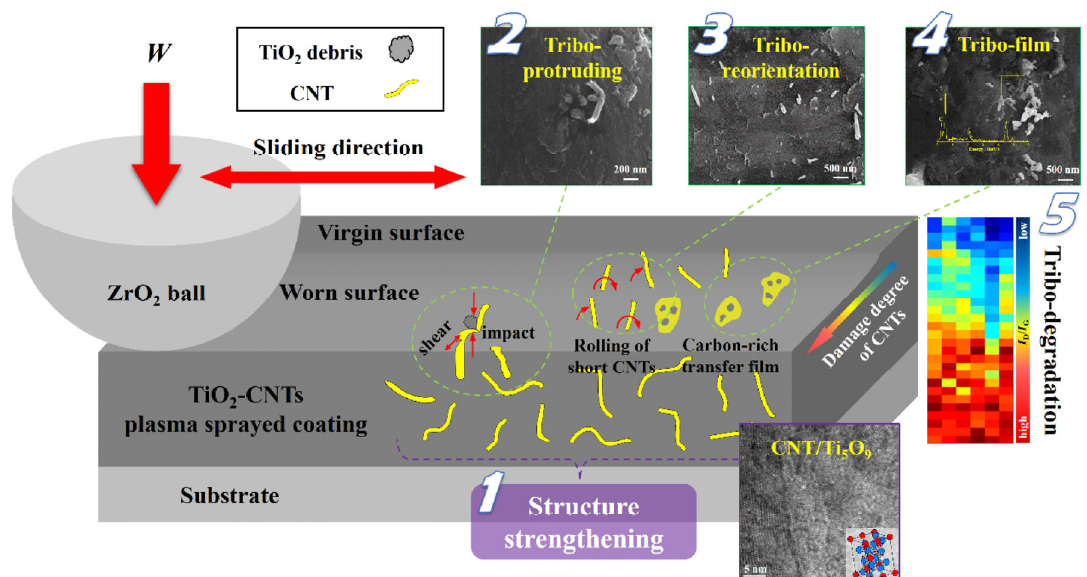
Fig. 17 Schematic illustration to reveal the CNTs induced wear mechanism for plasma sprayed ceramic coating: (1) structure strengthening, (2) tribo-protruding of CNTs, (3) tribo-reorientation of CNTs, (4) tribo-film of CNTs, and (5) tribo-defection of CNTs. Reproduced with permission from Ref. [183]. © Elsevier,